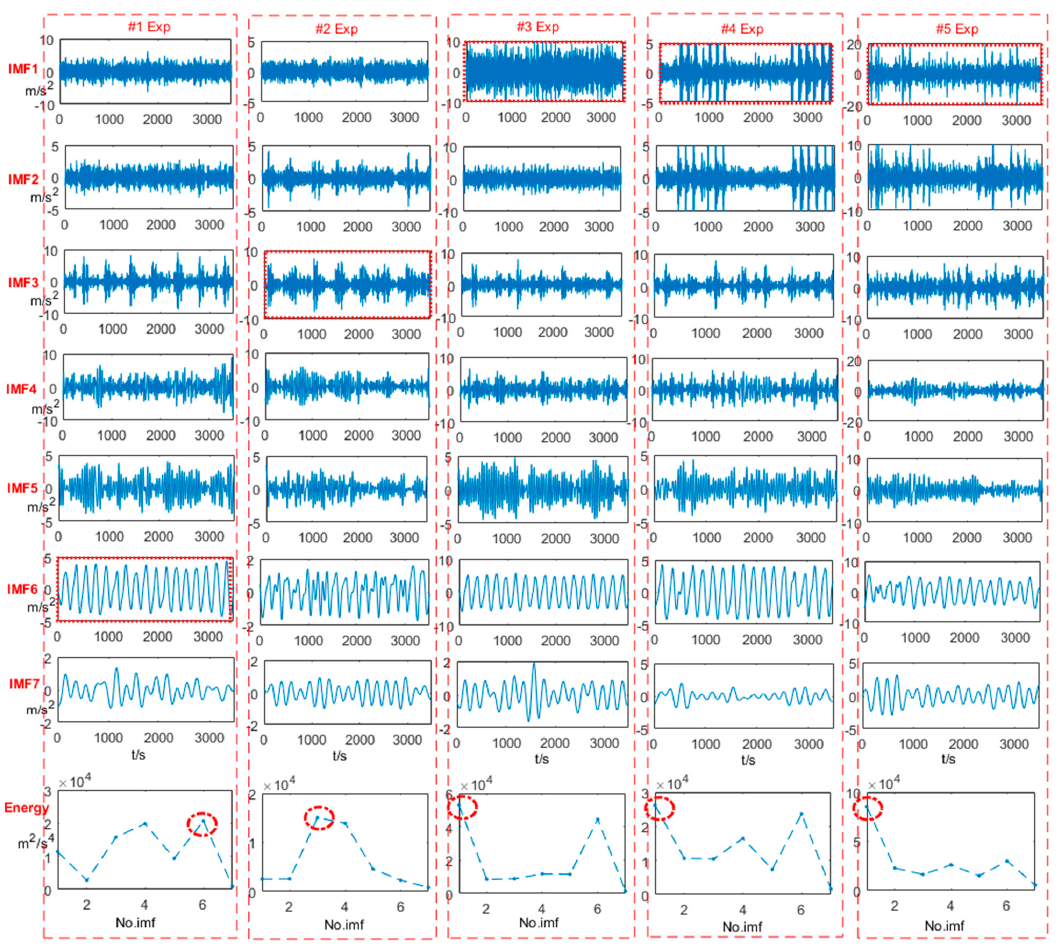
Figure 7. Vibration signals and their spectra for #1~5 Experimental bearings (#1: normal bearing; #2: bearing with outer race defect; #3: bearing with pin roller defect; #4: bearing with cage defect; #5: bearing with three kinds defects coupling)